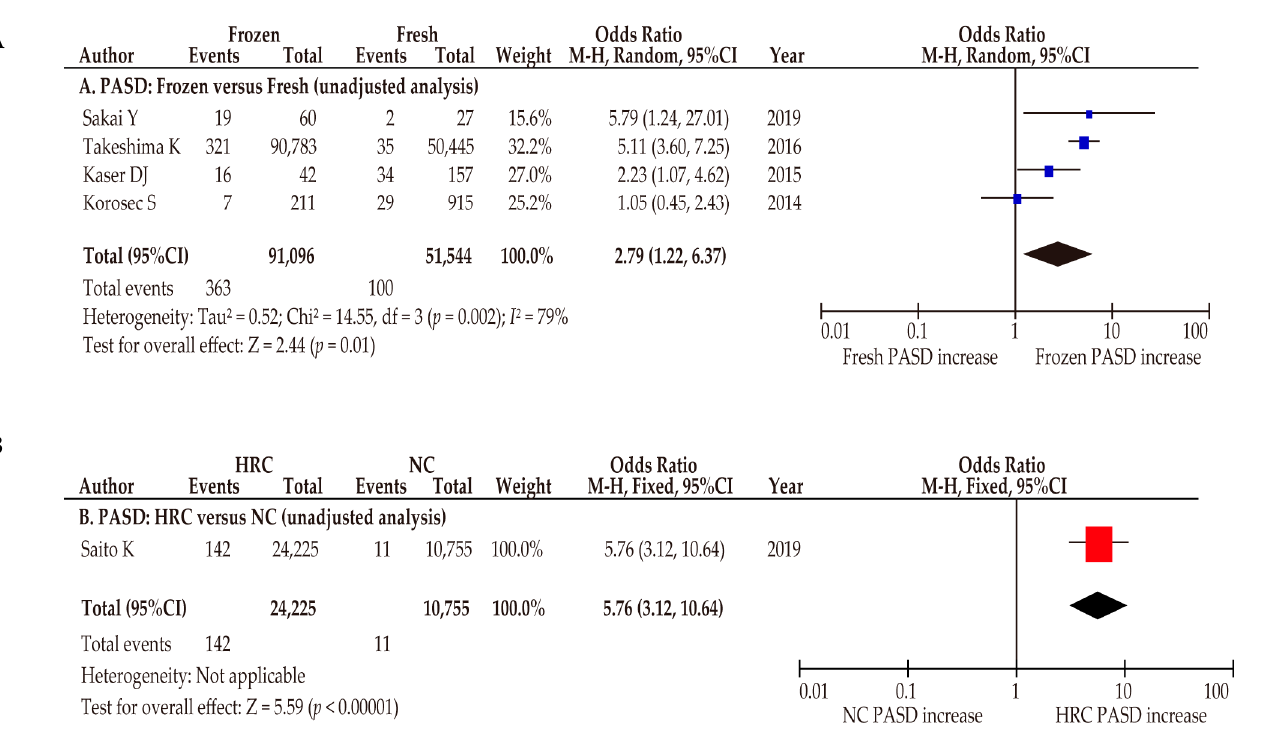
Figure 6. Effect of assisted reproductive technology on the incidence of placenta accreta spectrum (sensitivity analysis). The pooled odds ratios (ORs) for the unadjusted analysis of ( A ) comparisons between frozen embryo transfer (ET) and fresh ET and of ( B ) comparisons between the hormone replacement cycle (HRC) and normal cycle (NC) in one study. Forest plots were ordered within the stratum by relative weight (%) and the publication year of the study. Considerable heterogeneity was observed during both unadjusted analyses ( A : I 2 = 79%). Some values might be slightly different from the original values, as calculations were performed using RevMan ver. 5.4.1. Abbreviations: ART, assisted reproductive technology; OR, odds ratio; CI, confidence interval; SE, standard error; PASD, placenta accreta spectrum.